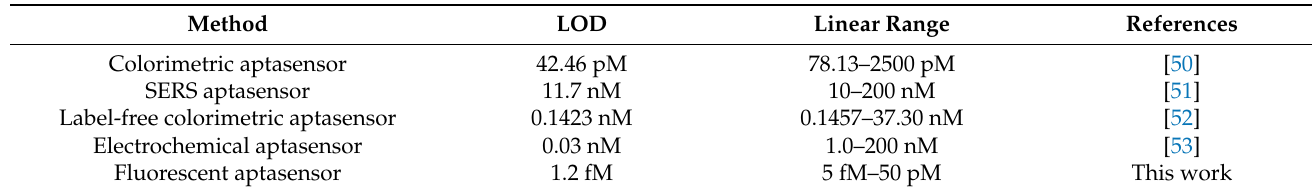
Figure 3. ( A ) Fluorescence intensity over a range of STX concentrations (5 fM, 50 fM, 500 fM, 5 pM, 50 pM). ( B ) The linear relationship between the intensity of fluorescence and the logarithm of STX concentration. ( C ) Fluorescence intensity of the aptasensor in the presence of different marine toxins, the concentration of STX is 50 pM, and others (OA, YTX, PTX) are 500 pM. Table 2. Comparison of different aptasensor performances for STX detection.